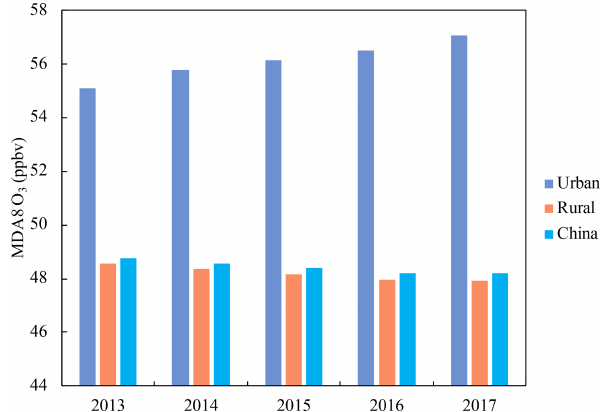
Figure 1. Trends of simulated MDA8 O 3 mixing ratios averaged in urban and rural areas and all land areas of China in summer (June– August) from 2013 to 2017. See Fig. S3 for the locations of urban and rural